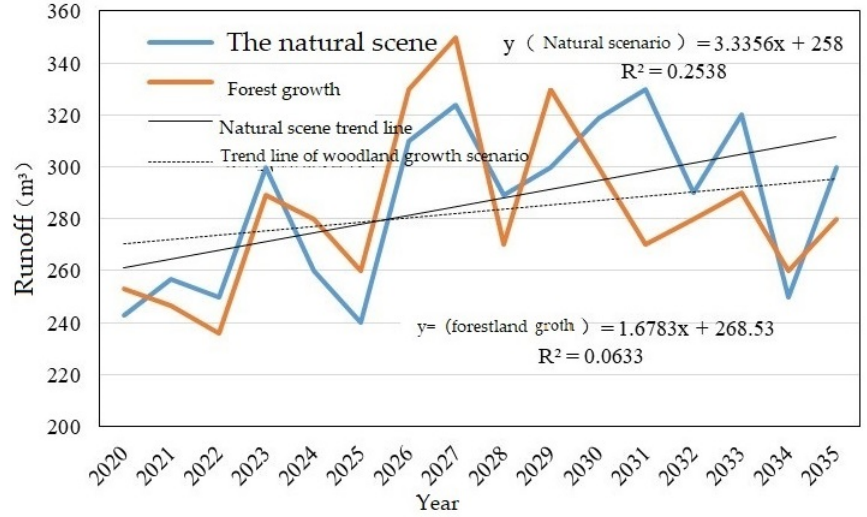
Figure 9. Future variation trend of runoff in the Weihe River basin of the Qinling Mountains in different scenarios.